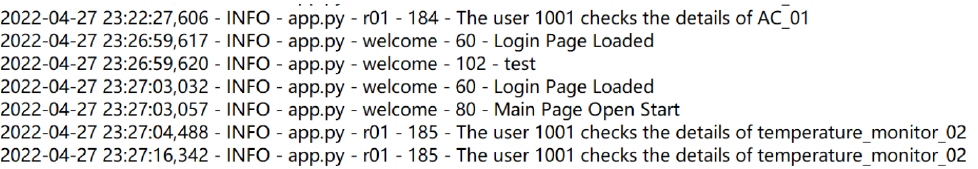
Figure 5. Operations